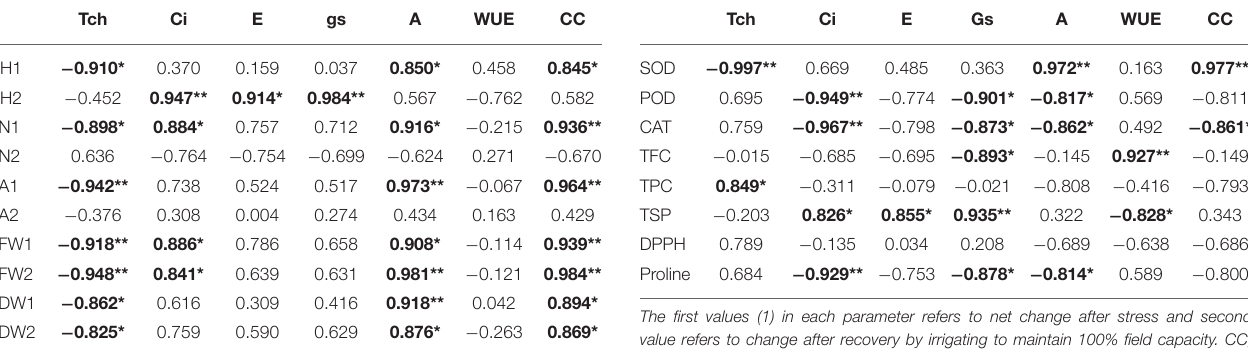
TABLE 6 | Correlation matrix of different physiological and biochemical attributes in guava cultivars under drought stress. Tch